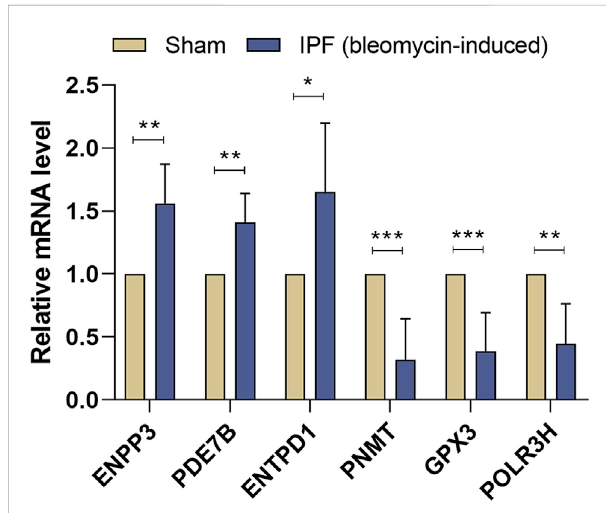
FIGURE 8 Validation of Key DEMRGs by qRT-PCR. Values represent means ± SD, n = 6/group. * p < 0.05; ** p < 0.01; *** p <